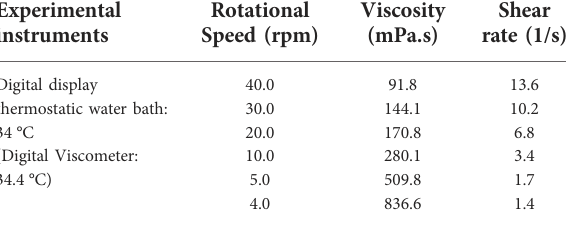
TABLE 4 Viscosity test data at a temperature of 34